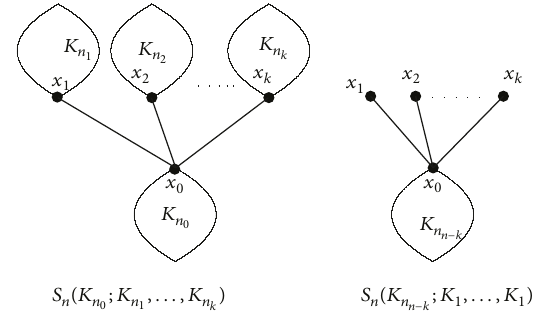
Figure 3: The graphs in Lemma 7 and in Theorem